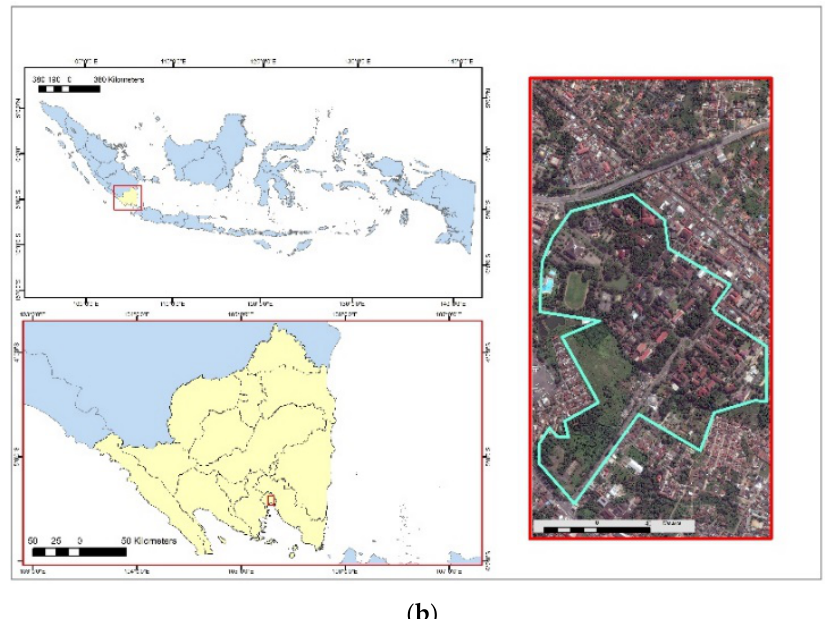
Figure 1. The research sampling locations were ( a ) Bunut Seberang Village, Lampung Province, Pesawaran District, Indonesia (test samples), and ( b ) University of Lampung, Lampung Province, Bandar Lampung, Indonesia (control samples).